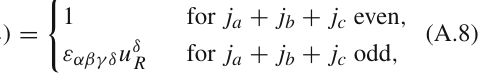
a region of high up-down asymmetry while the values 0 . 82 and − 2 . 32 correspond to a region of low up-down asymmetry. The magnitudes a = 1 . 01, 2 . 02 and 3 . 03 correspond to ratios of fractions between the two amplitudes of 0 . 62, 2 . 47 and 5 . 57, respectively